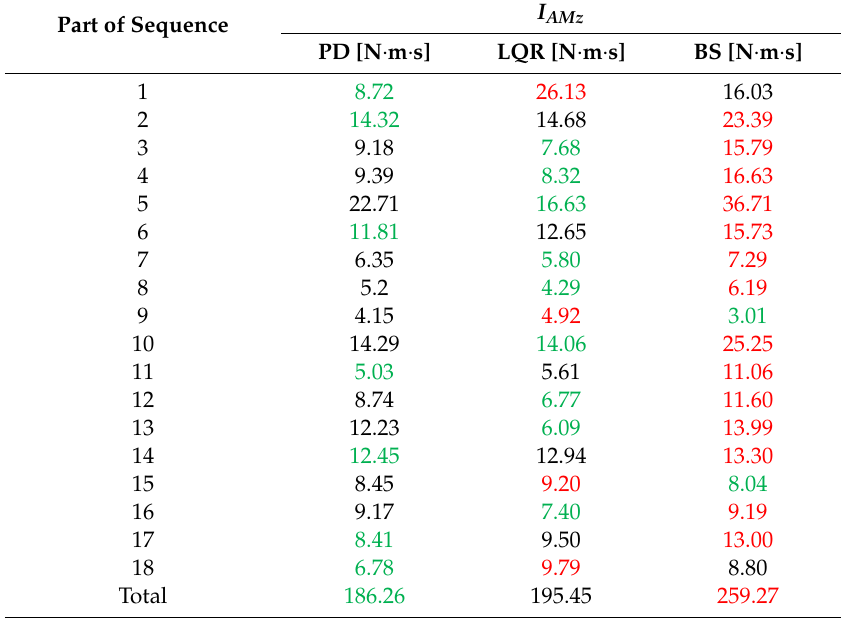
Table A5. Quality indicators of controllers’ performance: Integral of absolute desired torque around z axis ( I AMz ) (PD—PD controller, LQR—LQR controller, BS—backstepping controller).